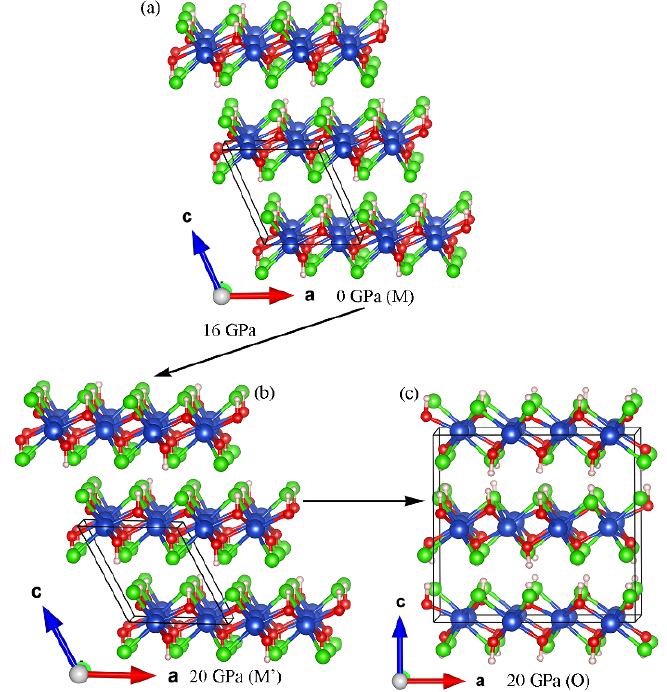
Figure 11. ( a ) and ( b ) show the crystal structures of Cu(OH)Cl in monoclinic at 0 GPa and 20 GPa, respectively. ( c ) shows the crystal structure of Cu(OH)Cl in orthorhombic phases at 20 GPa. The blue spheres represent Cu atoms, the red ones represent O atoms, the green ones represent Cl atoms, and the magenta ones represent H atoms.